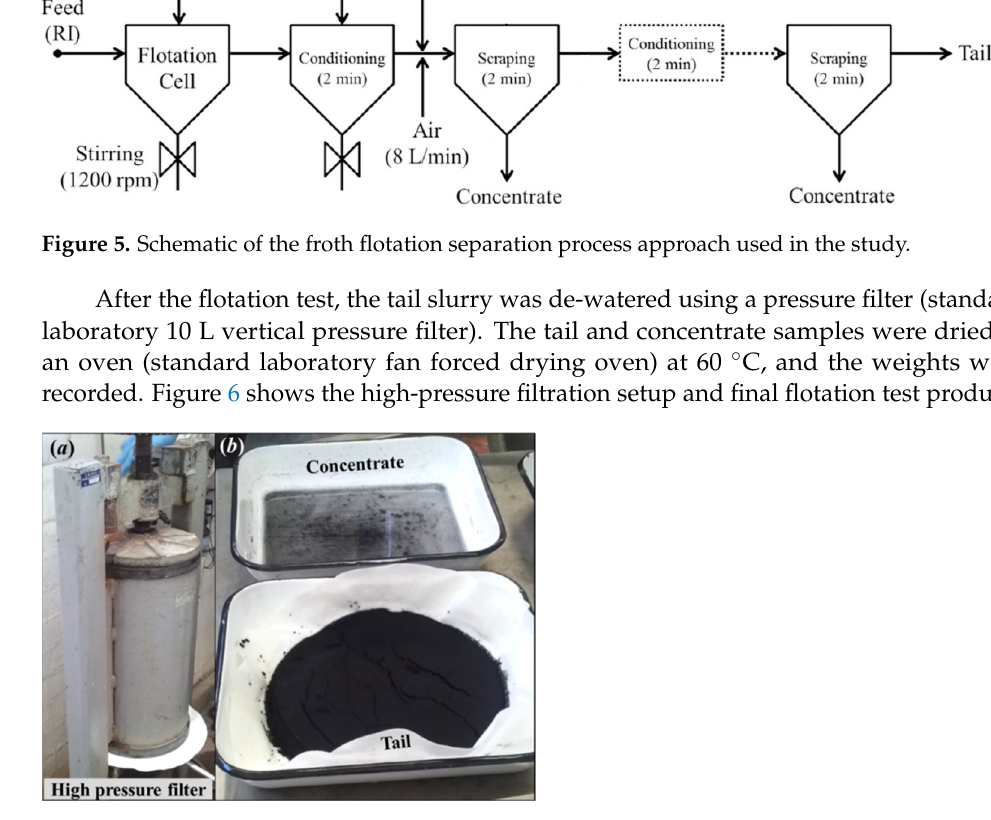
Figure 7. Secondary electron (SE) image of the sample after attritioning (feed for Flotation Test‒3). The sulphidised chrome spinel grains (shown by arrows) typically exhibit a brighter contrast than the RI grains. The particle size of the attritioned product was measured by laser sizing analysis (Malvern Mastersizer, Malvern Panalytical, Malvern, UK). The result is shown in Figure 8. It shows that the mean diameter over volume (D43) of the particles was 161 µm, which lies on the higher side of the generally accepted tolerance range (typically ~200 µm upper limit) for general flotation. This may have incurred a negative impact on the flotation.